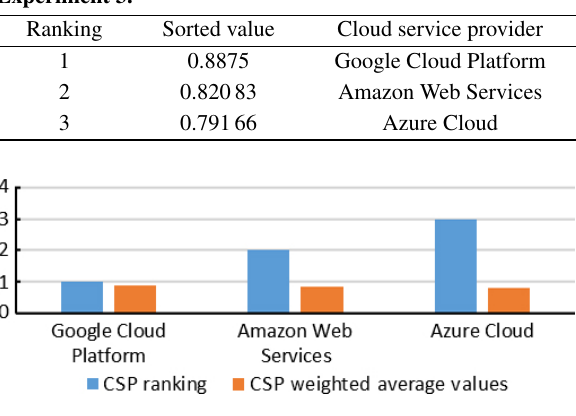
Fig. 6 Experiment 3 results.